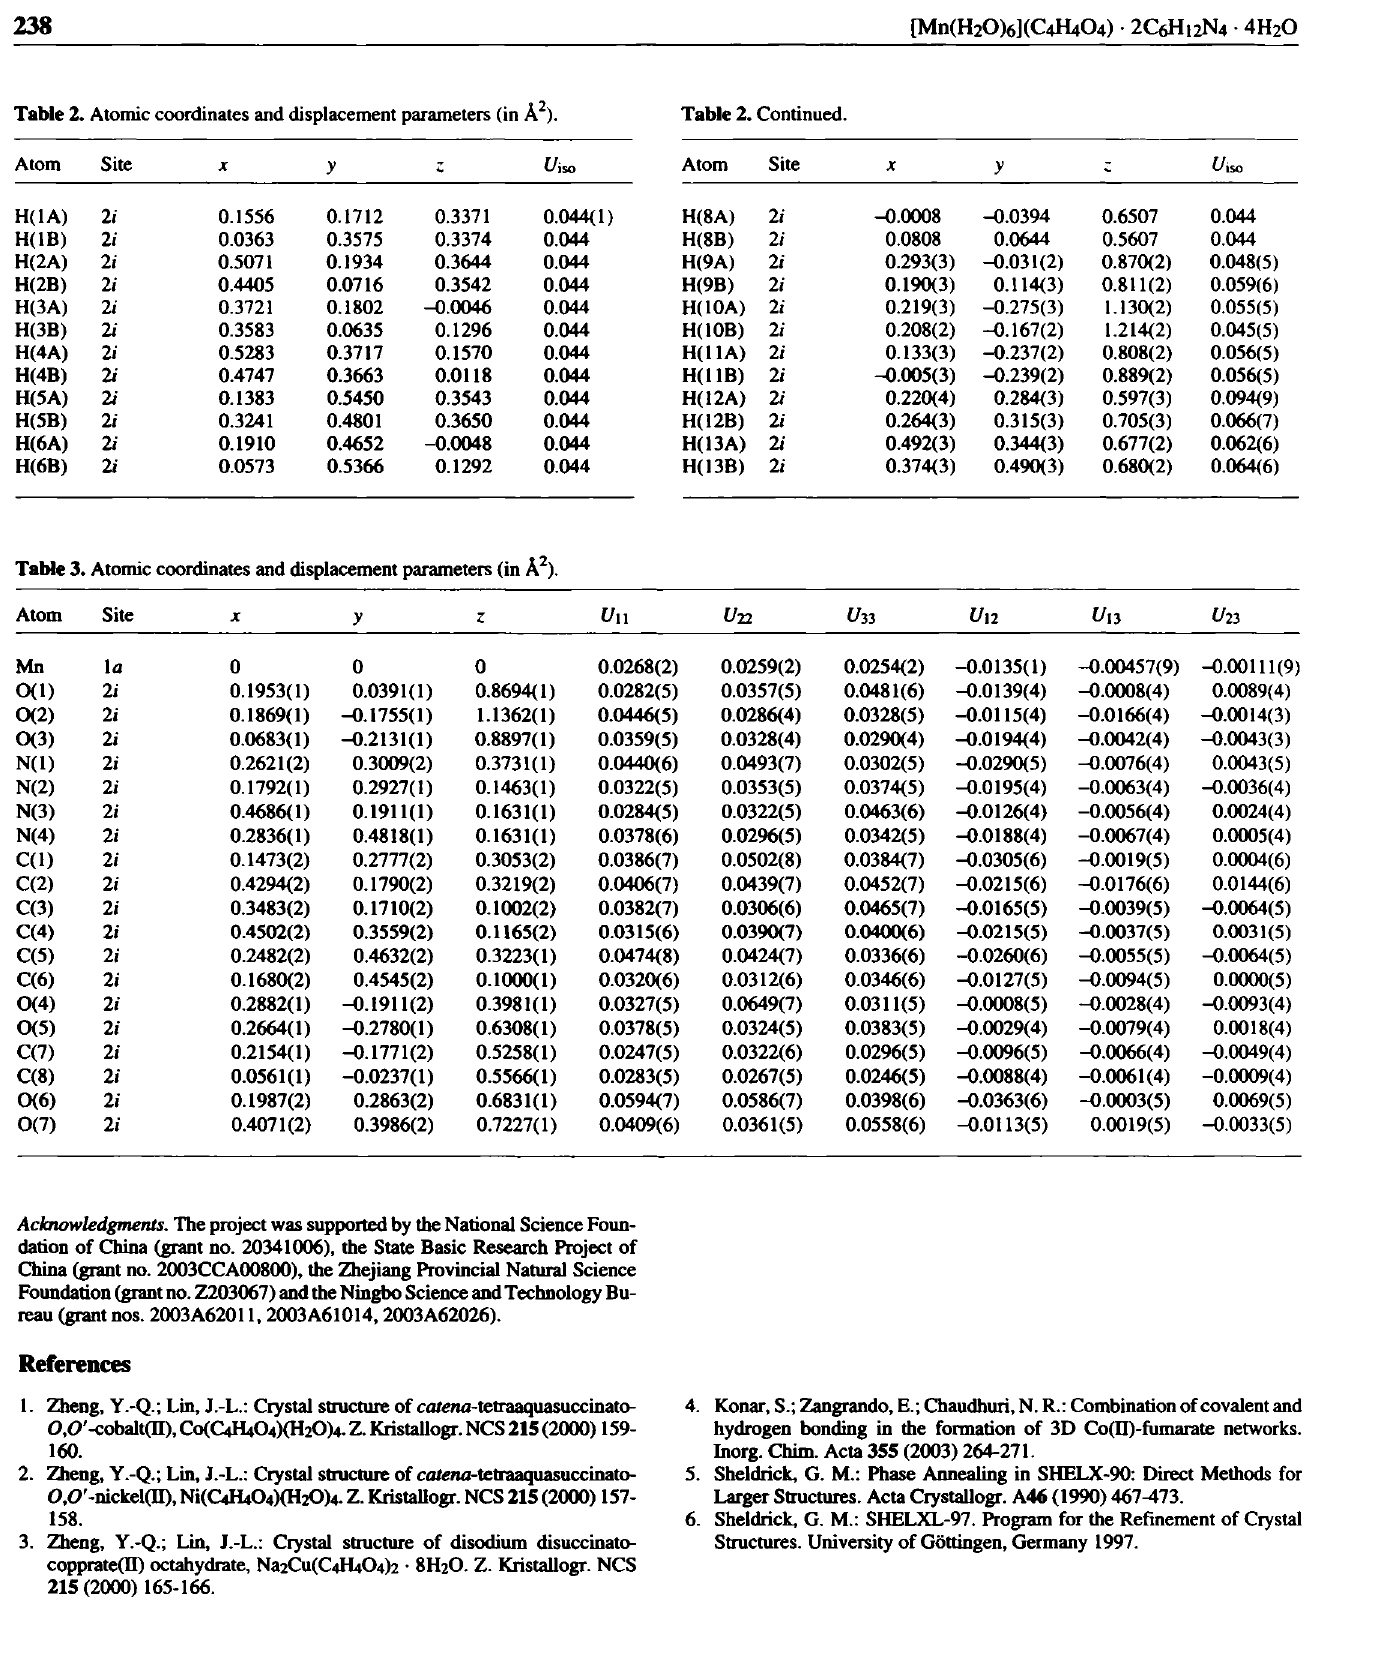
Table 2. Atomic coordinates and displacement parameters (in À 2 ). Table 2. Continued.